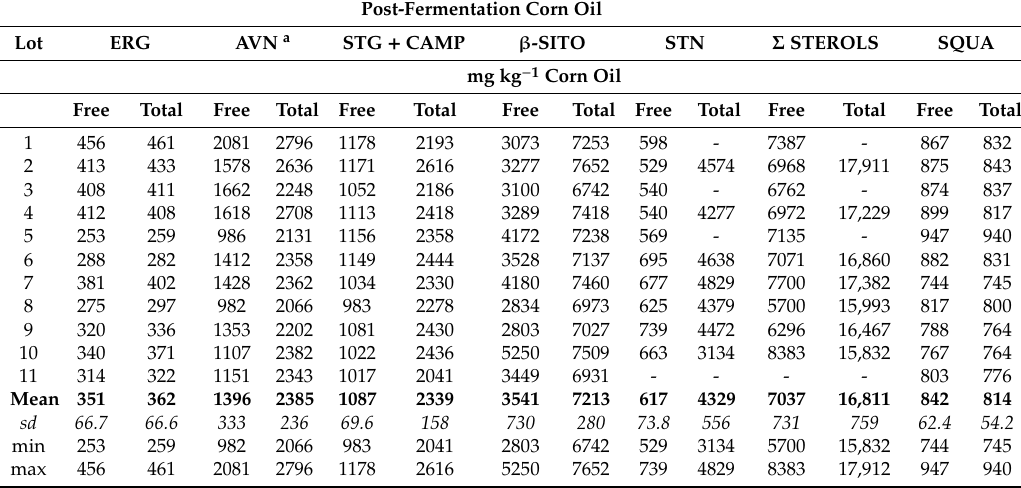
Table 1. Free and total amounts of phytosterols and squalene in post-fermentation corn oil from a dry-grind corn ethanol plant. Data refer to individual lots collected at monthly intervals from July 2018 to September 2019 and overall mean, standard deviation ( sd ), and range of values observed ( n = 11)